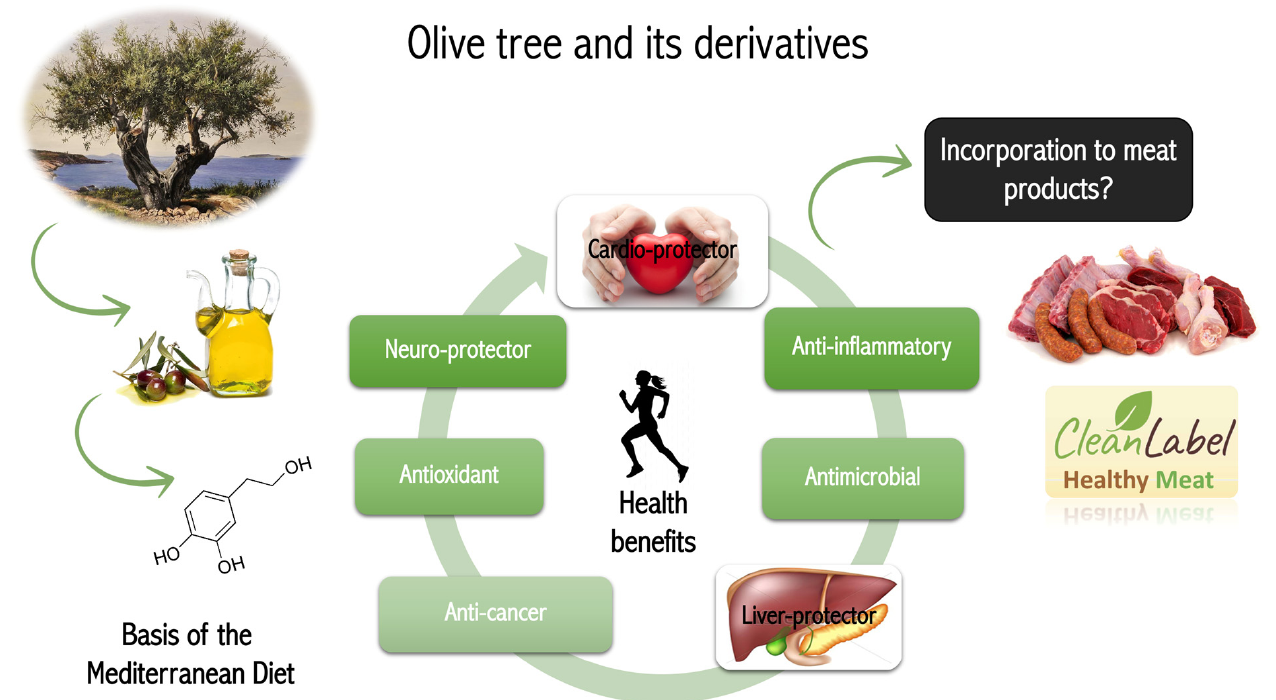
Figure 1. Schematic representation of HXT health benefits and its use as meat preservative.